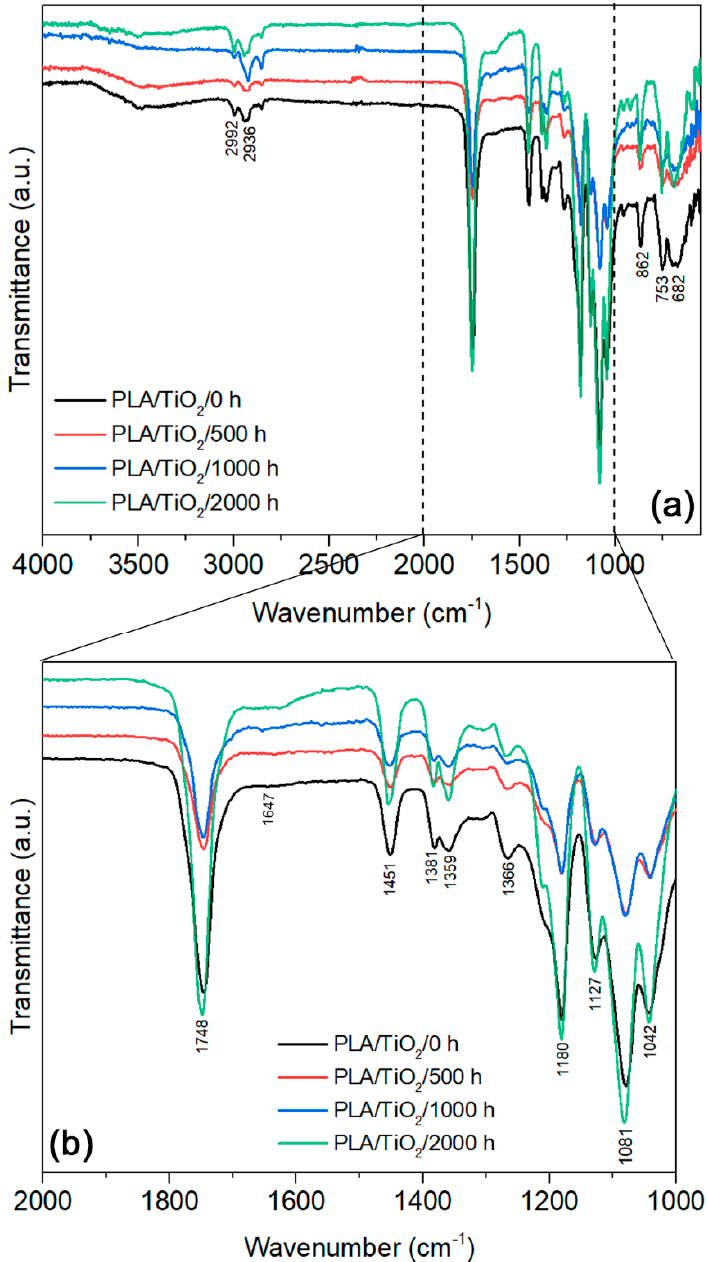
Figure 10. (a) FTIR spectra and the characteristic transmittance peaks of PLA / TiO 2 before (0 h) and after (500, 1000 and 2000 h) accelerated weathering. ( b ) Detailed area: C = C shoulder at 1647 cm − 1 .